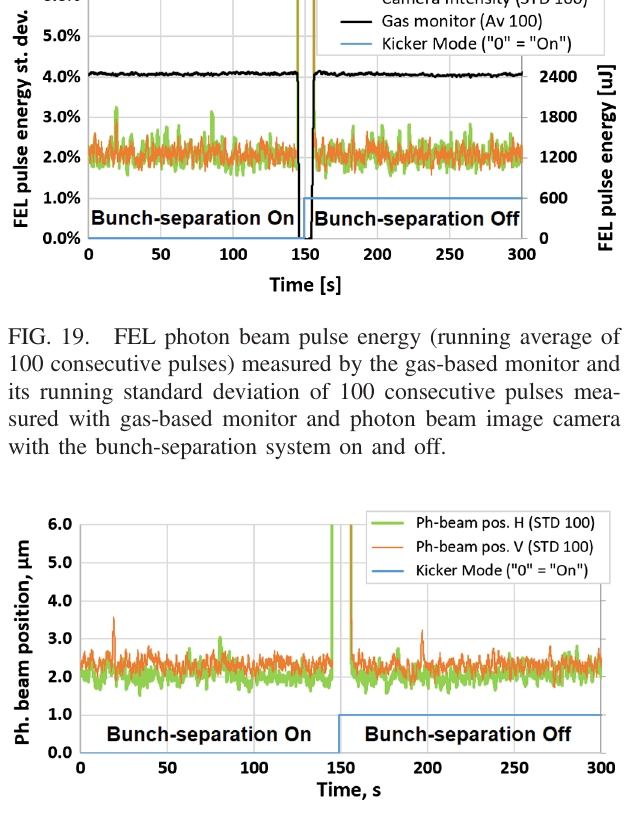
FIG. 20. FEL photon beam horizontal and vertical position standard deviation of 100 consecutive pulses with the bunch- separation system on and